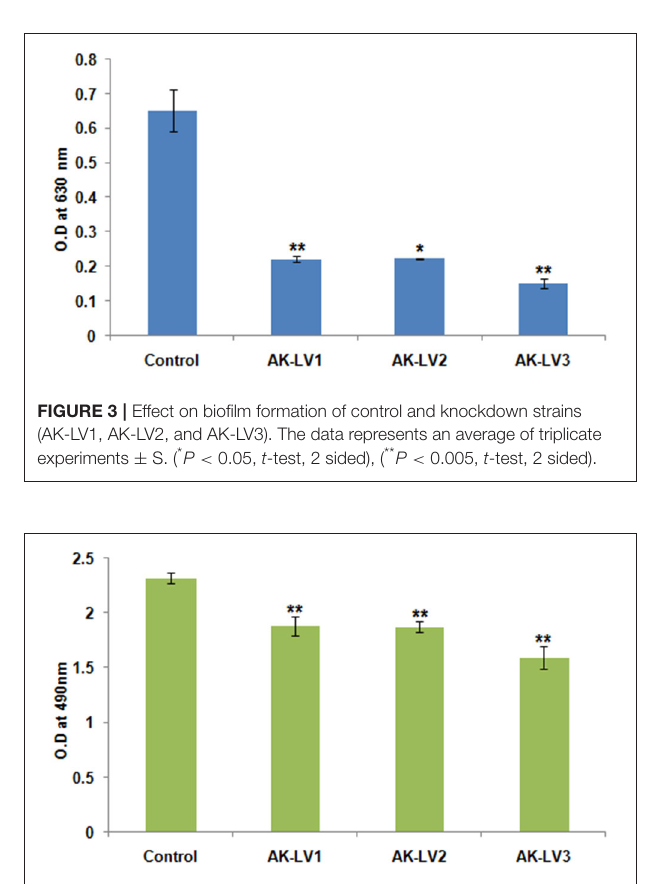
FIGURE 4 | Effect on cell viability and metabolic activity. The data represents an average of triplicate experiments ± SD. ( ** P < 0.005, t -test, 2